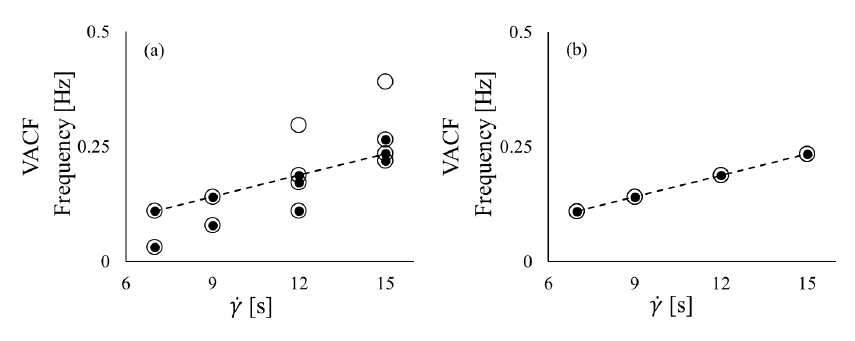
Figure 12: The dominant frequencies in the velocity autocorrelation function (VACF) spectra plotted as a function of applied shear rate for (a) the velocity in the spatial center of the high shear band and (b) the velocity in the spatial center of the low shear band. Filled black circles are protocol 1 and open circles are protocol 2. Dashed lines correspond to the rotationally correlated